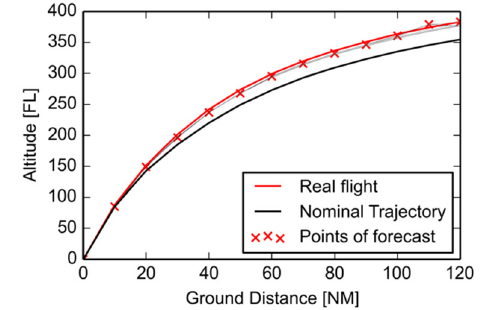
Figure 12. Sample in-flight uncertainty calibration for a flight with a payload of 10,000 kg in weather scenario (C). The forecast after 10 NM calculated in ISA (grey lines with red crosses) already matches the flight profile under real and uncertain weather conditions (red). Red crosses indicate the predicted altitude at the next slice. The nominal trajectory (black) with ATOM = E(X) = 63,488 kg in ISA is significantly deviating from the real trajectory.